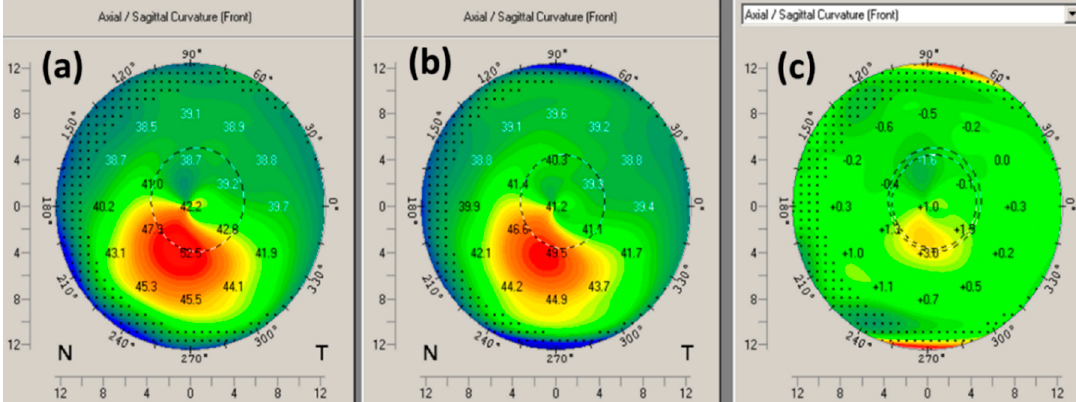
Figure 3. A representative example of corneal tomography at preoperative ( a ), 1-year postoperative ( b ), and the difference map showing the change in corneal tomography ( c ).